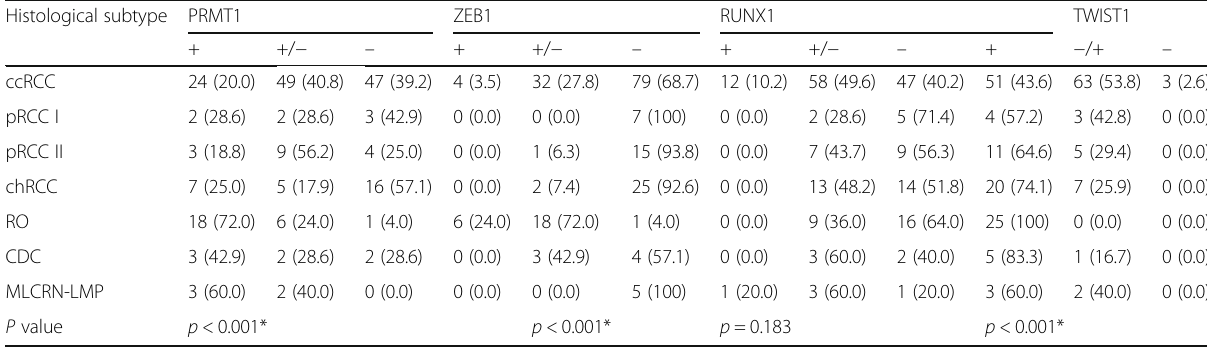
Table 4 Heterogeneity of PRMT1, ZEB1, RUNX1 and TWIST1 immunohistochemical expression among different tumor types Histological subtype